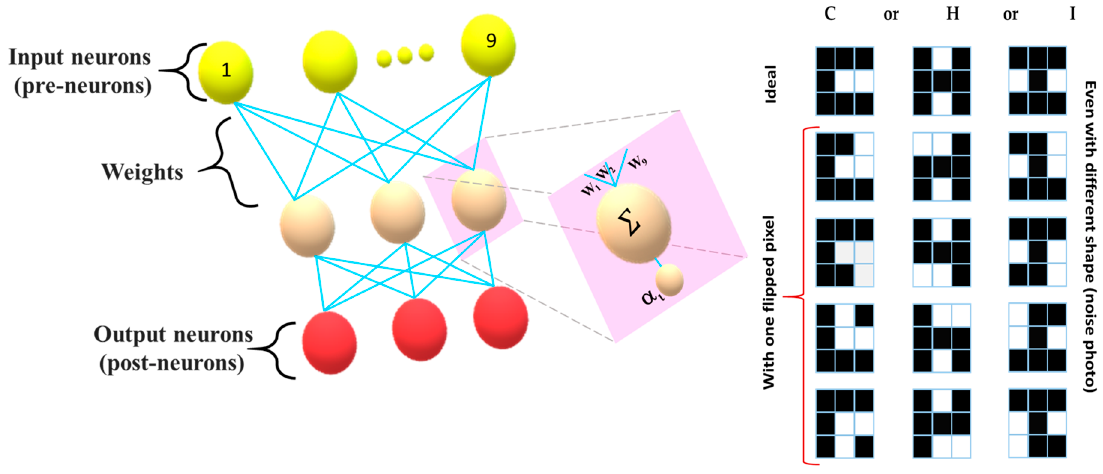
Figure 8. Three layers of neural network and the set of used patterns.